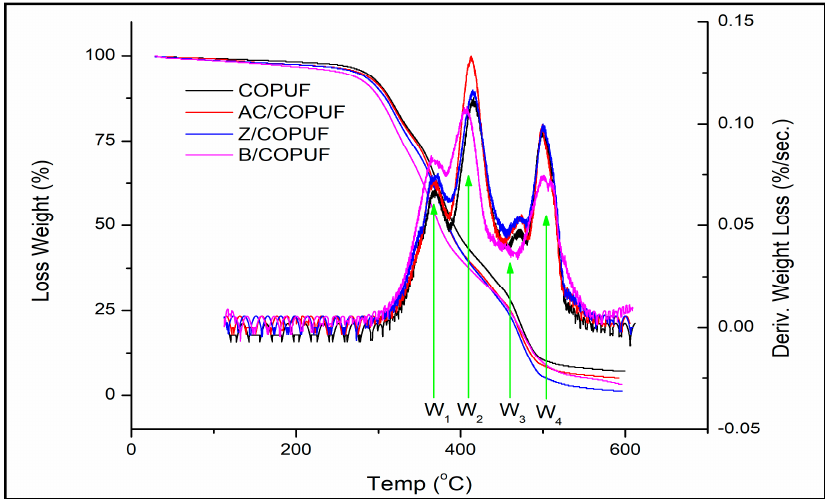
Figure 6. TGA and DTGA of COPUF, AC/COPUF, Z/COPUF, and B/COPUF with four stages of thermal degradation indicated by W 1–4 .